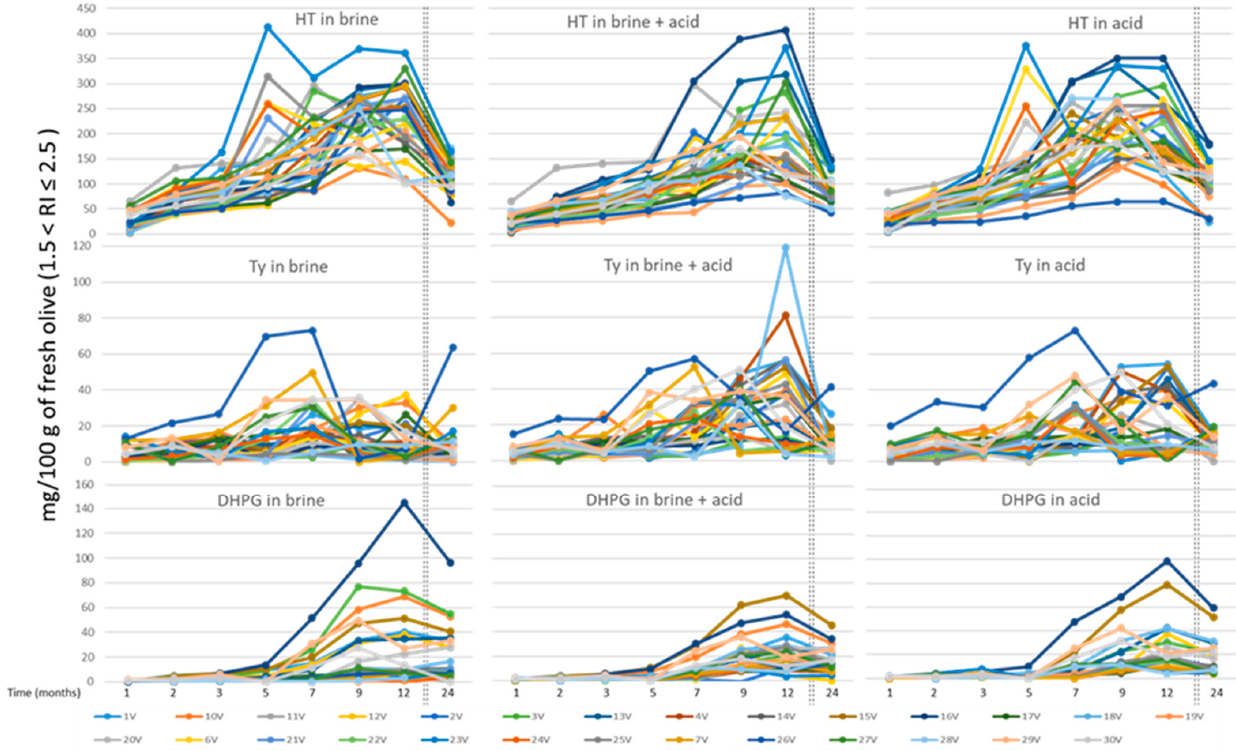
Figure 2. Solubilization of HT, Ty, and DHPG during 24 months in three different storage liquids (brine, brine in acid, and acid) for thirty varieties of olives with a ripeness index between 1.5 and 2.5.